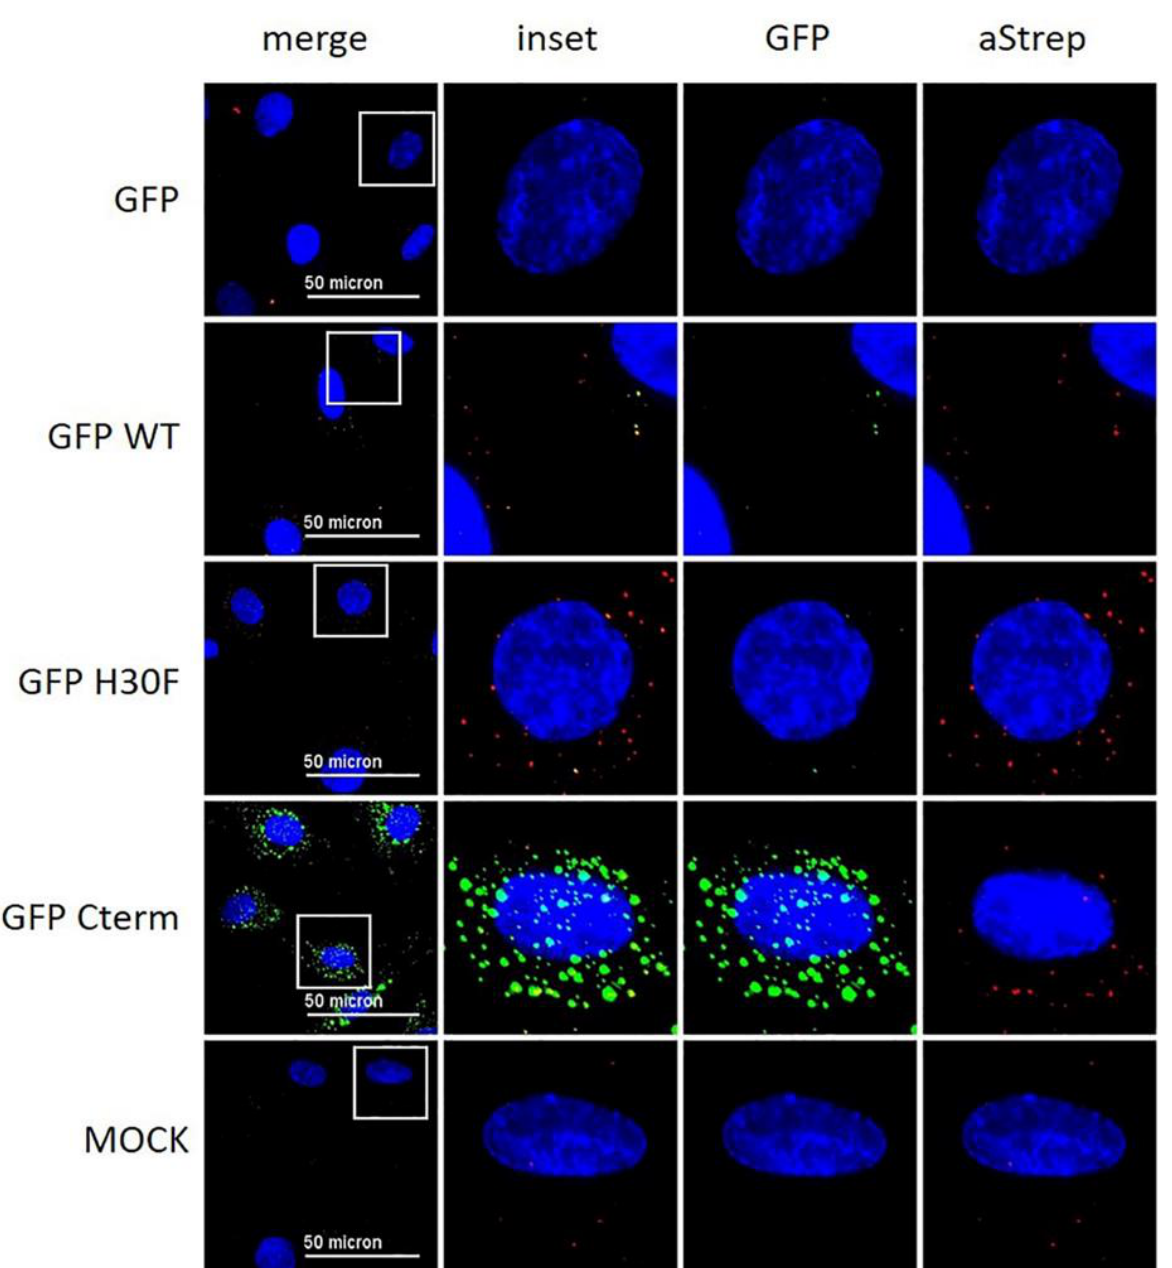
Figure 8. Immunofluorescence analysis of GFP-E rns fusion proteins with anti-Strep-tag antibody. As indicated on the left side, GFP alone (“GFP”) and various GFP-E rns fusion proteins ( “GFP - WT”: GFP-wt E rns ; “GFP H30F” : GFP-E rns -H30F; “GFP Cterm”: GFP-E rns -C-terminal end) at a concentration of 10 ng /μL were incubated on BT cells for 30 min. E rns was detected by immunofluorescence microscopy as described in the Methods Section using a primary antibody against the Strep-tag present at the C-terminus of each construct and a secondary antibody conjugated with Alexa 647 fluorophore (red). The fluorescence signal of GFP (labeled on top) is shown in green. Nuclei were stained with DAPI (blue) present in the mounting medium. Adjustment of contrast and brightness was carried out with Fiji using the same setting for mock and all constructs. For each picture, an area was selected (white square), and the merged picture (inset) and each individual color are displayed magnified to the right-hand side. One representative experiment out of two is shown.